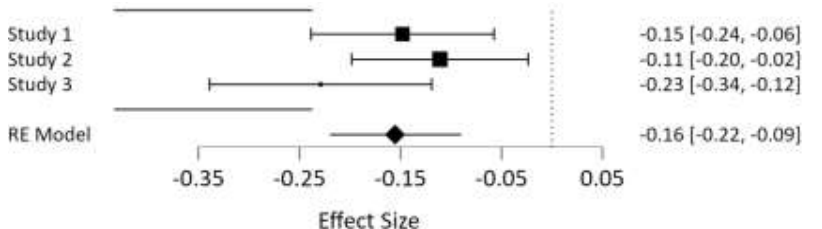
Figure 23. Forest plot of meta-analysis of Amotivation and L2 test